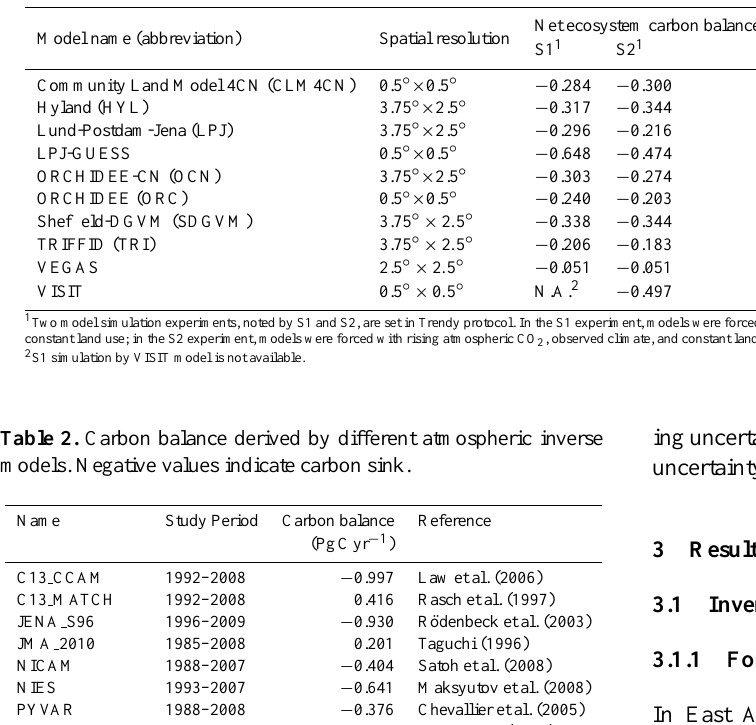
Table 1. Carbon balance derived by different carbon cycle models.